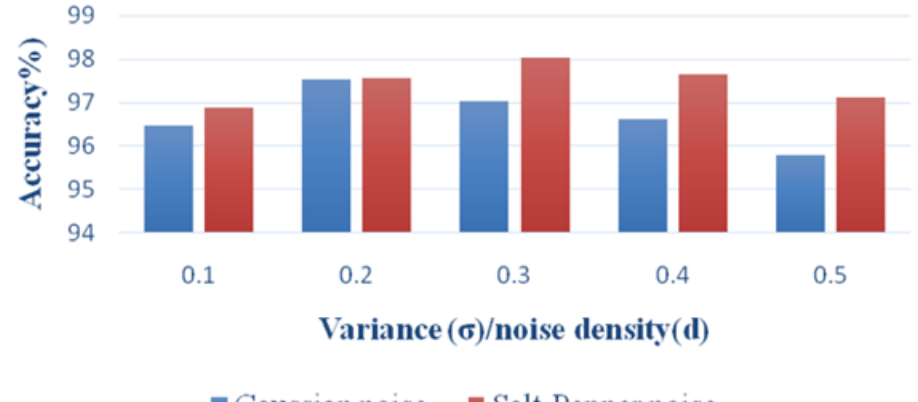
Figure 9. Recognition rate on degraded images of the LAG dataset.